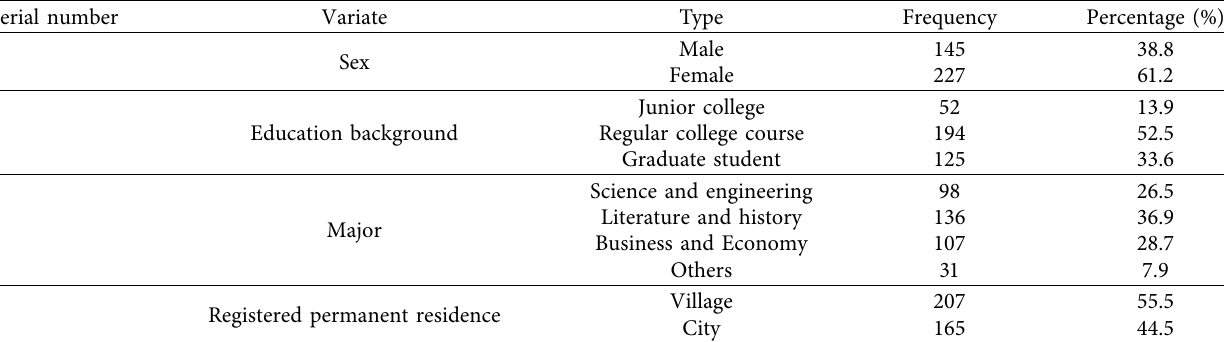
Table 2: Distribution of samples.